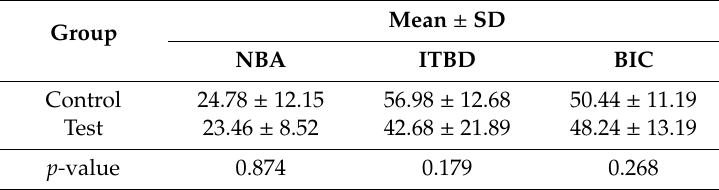
Table 4. Histometric analysis within regions of interest (%) ( n =